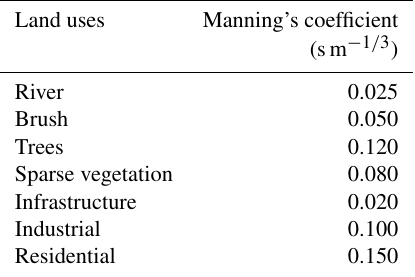
Table 6. Manning’s coefficients of the numerical